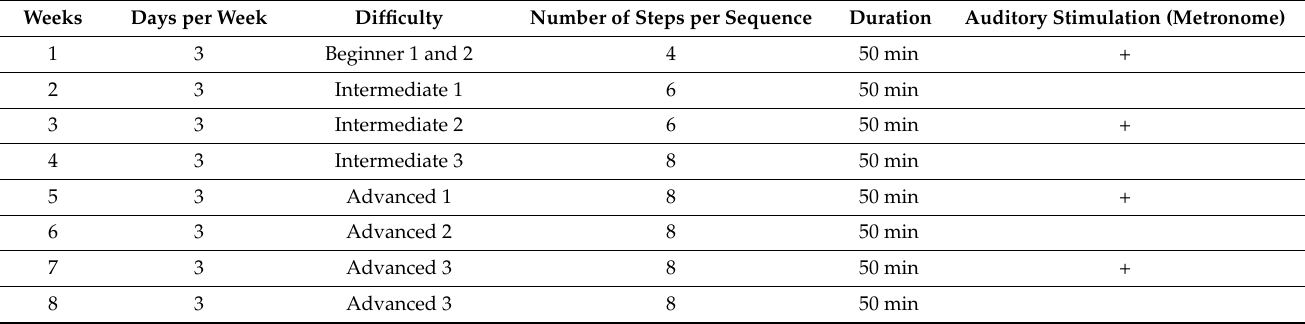
Table 1. Square Stepping Exercise training